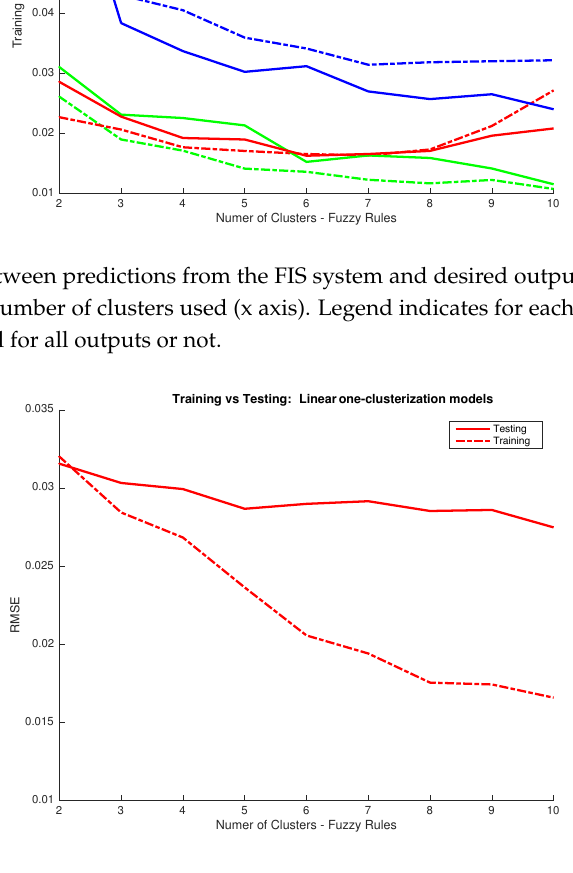
Figure 11. RMSE between predictions from FIS system using the same clusterization for all inputs and linear activation functions and desired outputs in the RGB training and testing datasets (y axis) vs. number of clusters used (x